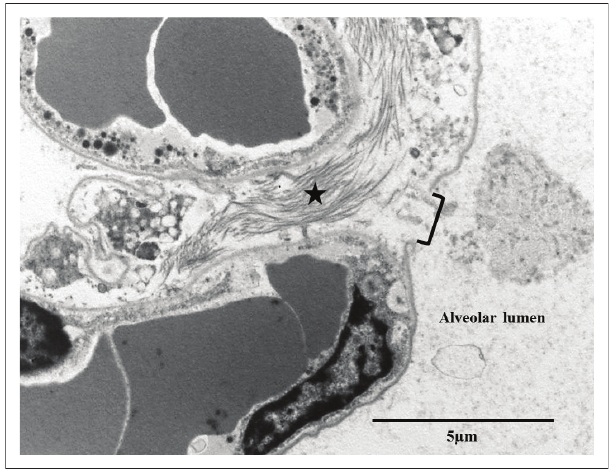
Source : Image taken by Erna van Wilpe FIGURE 7: Fibroblast (1) within the alveolar septum and an intra-alveolar fibroblast (2) in an area of septal membrane (arrows) disruption. Note dilated endoplasmic reticulum in fibroblasts and interstitial collagen fibrils (stars)